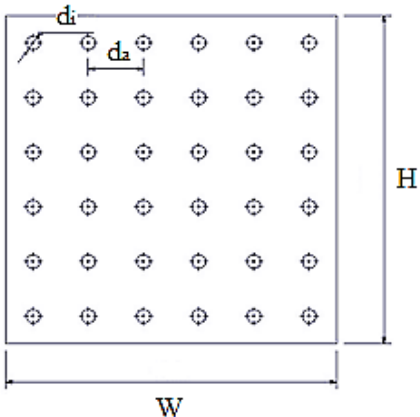
Figure 2. SHTES module, frontal